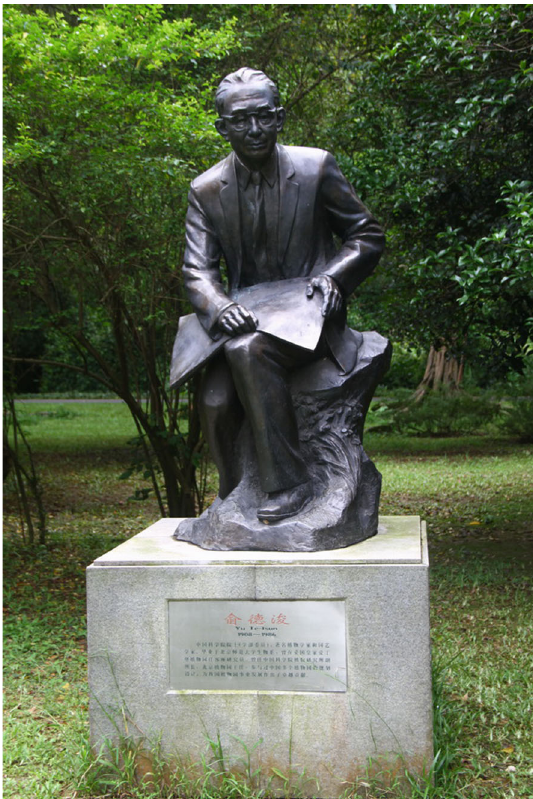
Figure 2. Bronze Statue of Prof. Dejun Yu located in South China Botanical Garden, Chinese Academy of Sciences (SCBG,